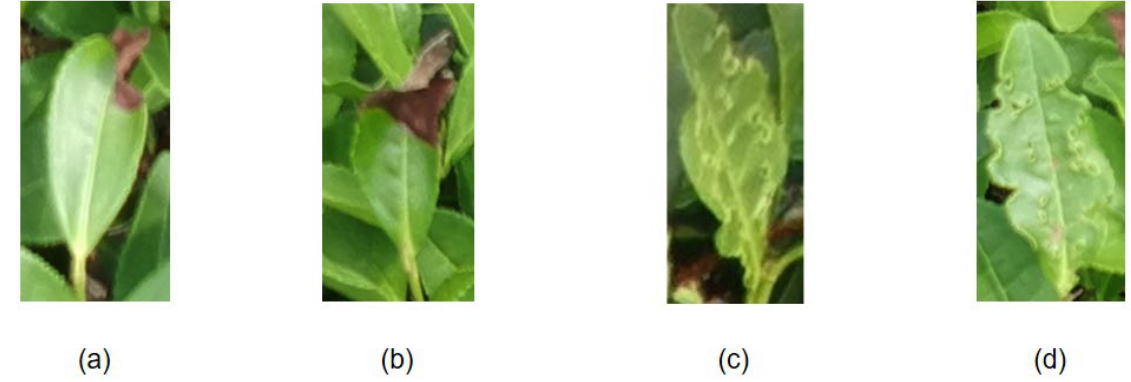
Figure 1. Some representative samples of our dataset. ( a ) Tea leaf blight; ( b ) tea leaf blight; ( c ) green mirid bug; ( d ) green mirid bug.